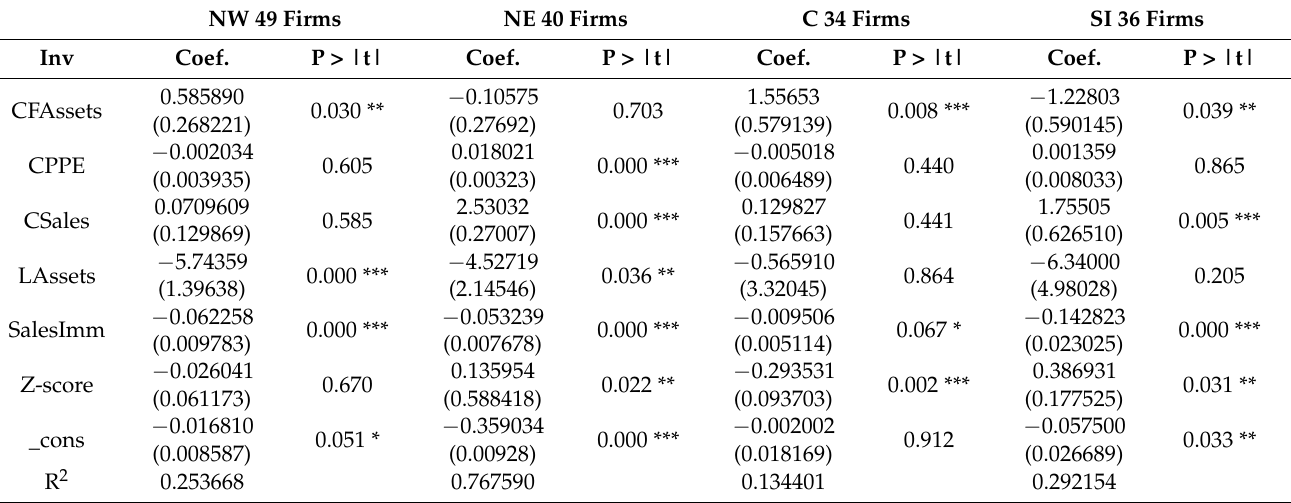
Table 2. WLS model for geographical